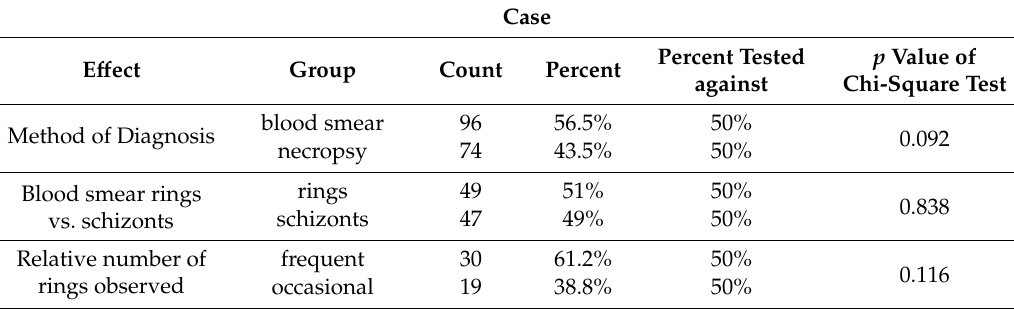
Table 6. Statistical analysis of diagnostic method, blood smear diagnosis, and relative number of signet ring form e ff ects on acute cytauxzoonosis case